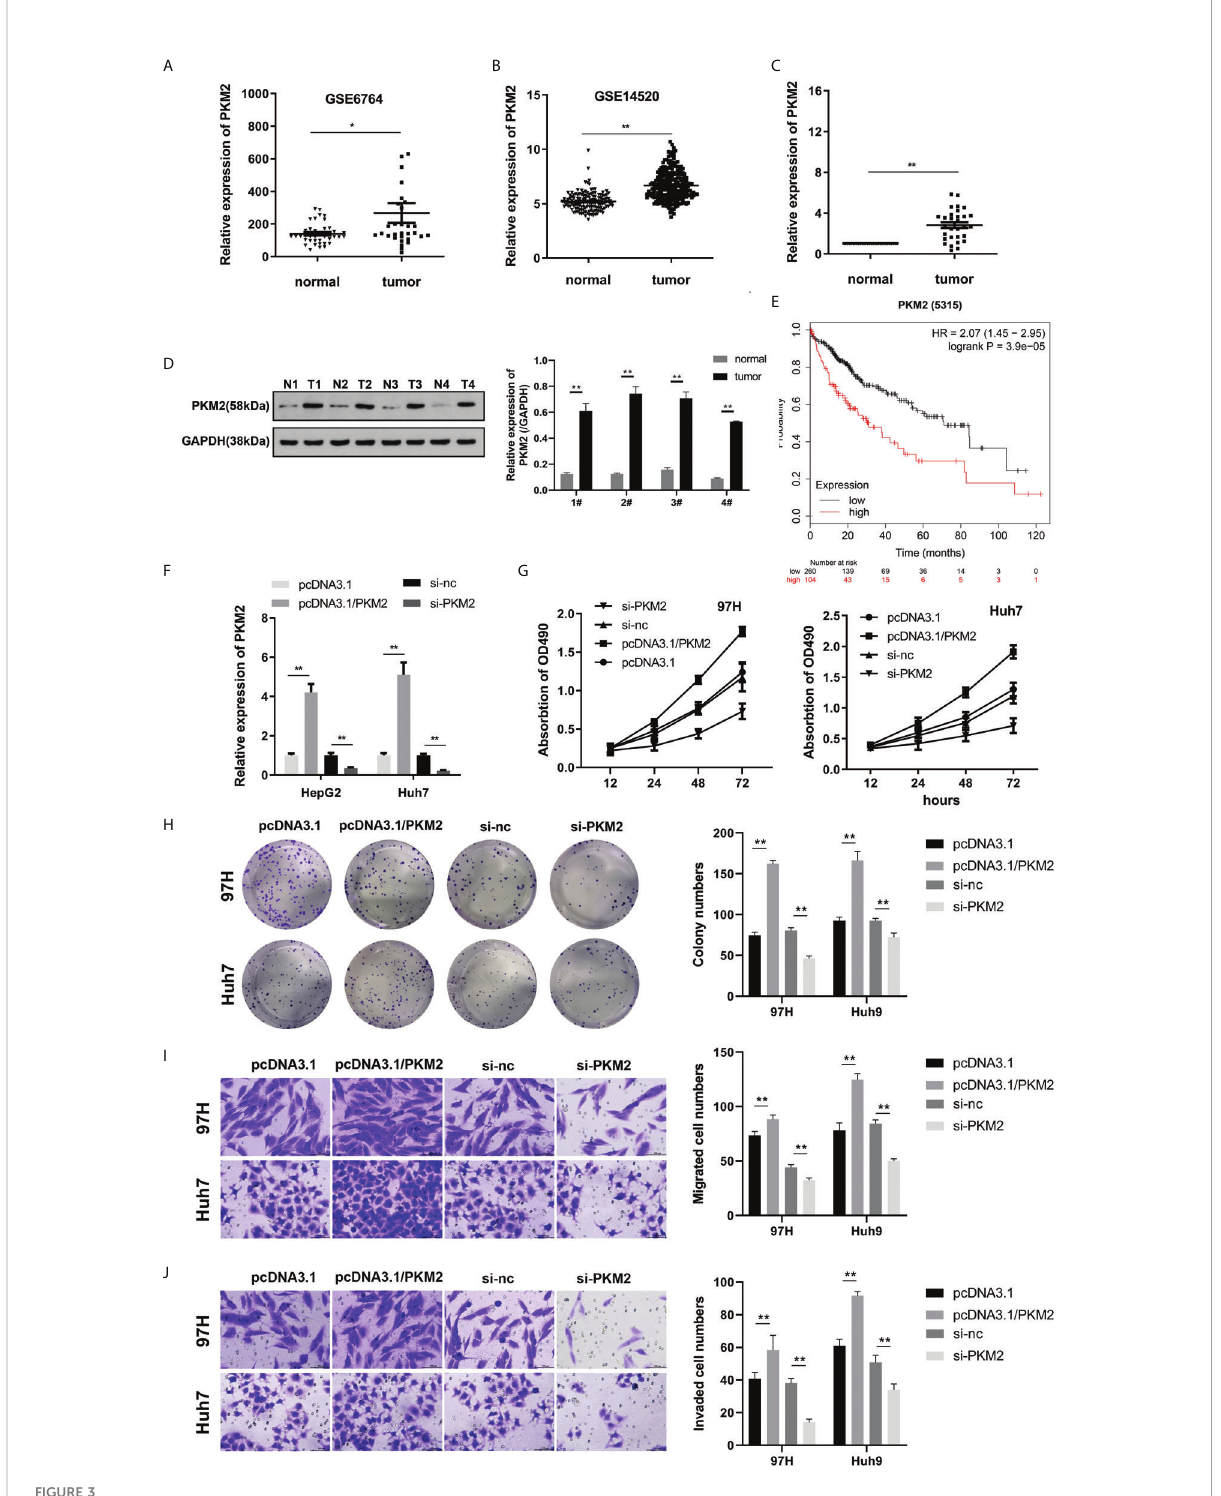
FIGURE 3 PKM2 is highly expressed in HCC, and knockdown of PKM2 can inhibit the viability, proliferation, migration, and invasion of HCC cells. (A, B) The expression of PKM2 based on the GSE6764 and GSE14520 datasets from the GEO database was analyzed. (C) The expression of PKM2 in the tissues was detected using qPCR. (D) Western blot was used to detect PKM2 expression in tumor tissues. (E) Survival analysis con fi rmed that PKM2 was associated with the prognosis of HCC. (F) qPCR was performed to detect PKM2 after overexpression or knockdown. (G) Cell viability was assessed using the MTT assay. (H) Clone formation detection of proliferation was carried out. (I, J) A Transwell assay was carried out to evaluate cell migration and invasion. * indicates P < 0.05; ** indicates P <